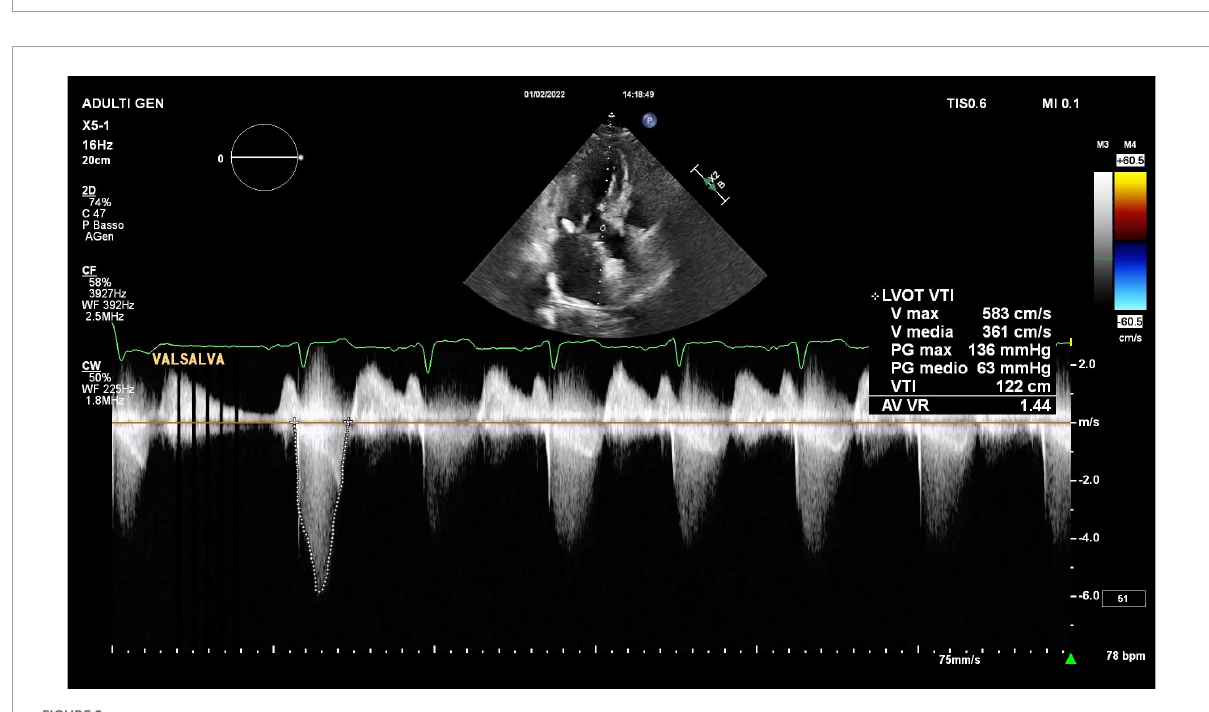
FIGURE2 Two-dimensional trans-thoracic echocardiogram continuous wave Doppler representation of LVOT peak gradient at rest and during Valsalva maneuver.